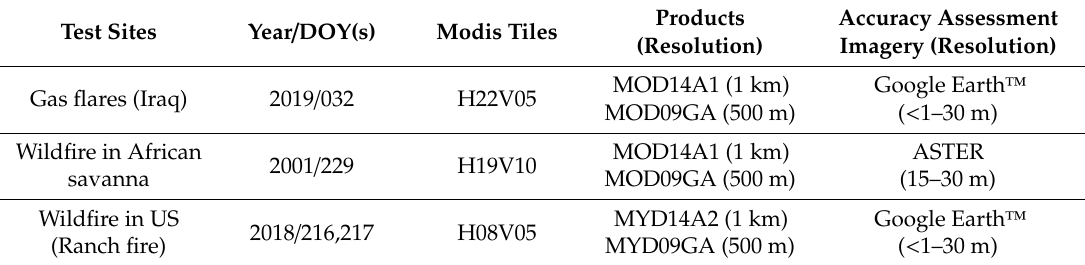
Table 1. Algorithm assessment test site location, MODIS image day of year (DOY), MODIS tile, MODIS product, and accuracy assessment